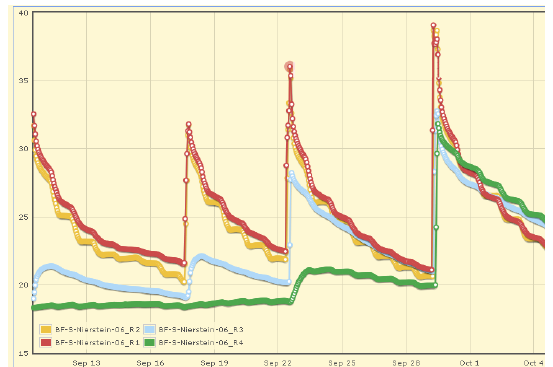
Figure 5. Exemplary measurements of soil moisture in different depths by one